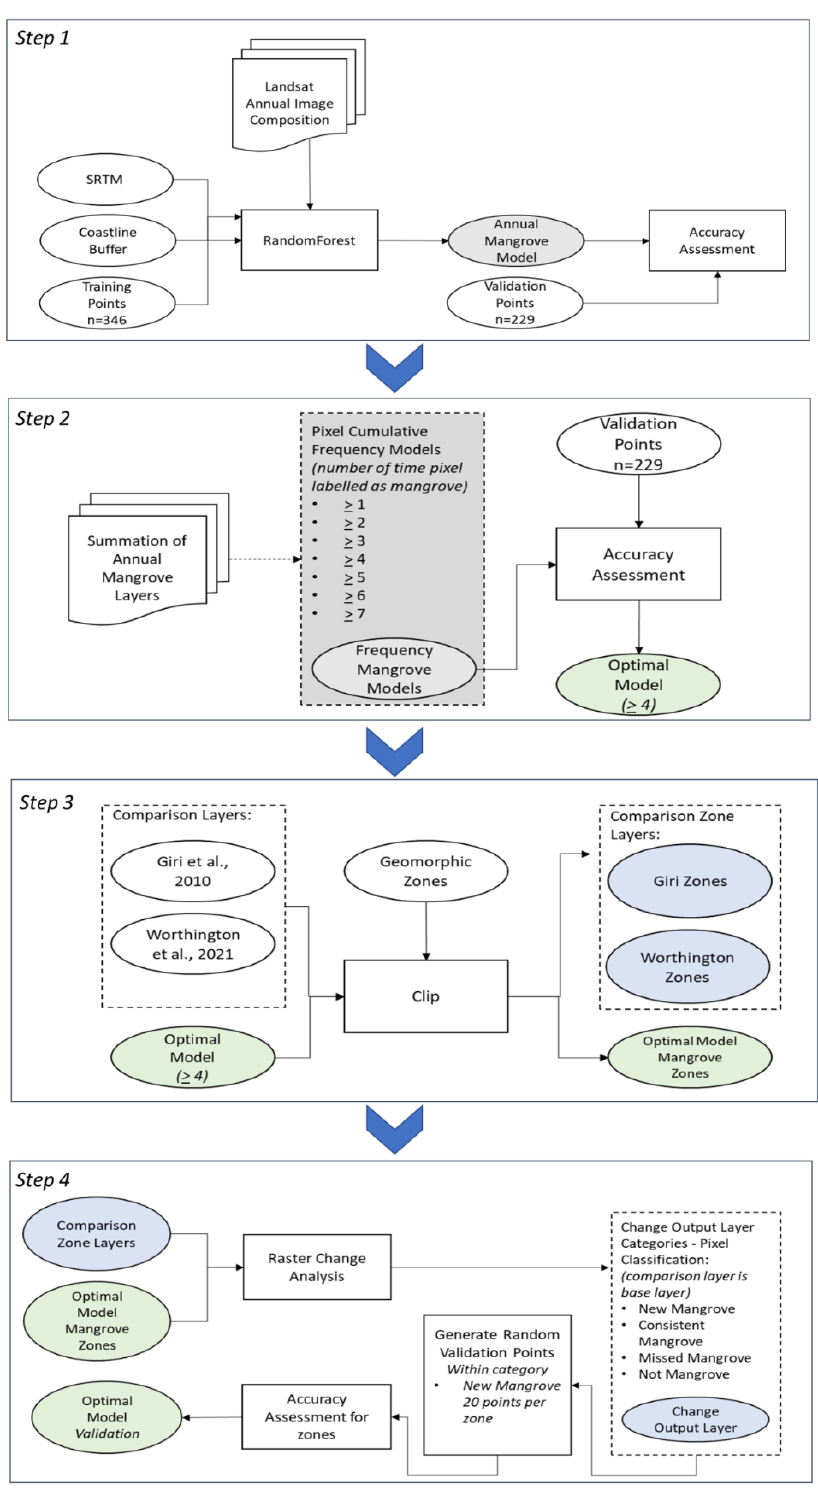
Figure 2. The four main steps involved in the MSTRF method. (1) Development of each annual image composite and subsequent generation of annual mangrove model developed using randomForest, (2) identification of the optimal timeframe through the accuracy assessment of model combinations, (3) exploration of the optimal model at the geomorphic zones and (4) further validations of additional mangrove areas at the zone